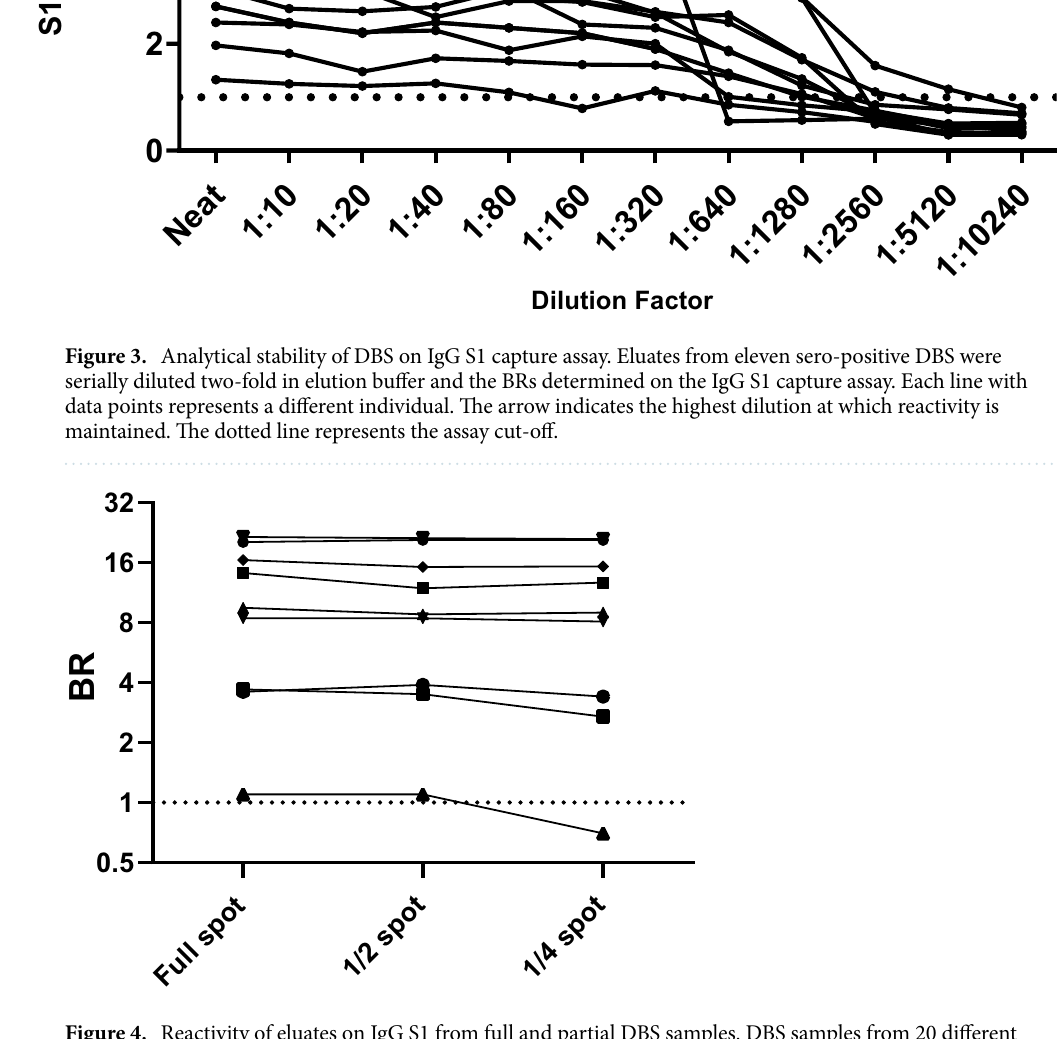
Figure 4. Reactivity of eluates on IgG S1 from full and partial DBS samples. DBS samples from 20 different patients were extracted as full, half and quarter spots as described in the methods. The reactivity of the three resulting eluates from each individual was tested in the IgG S1capture. The resulting reactivity (BRs) of the full, half and quarter spot eluates is shown for each individual, each line representing a different individual. The dotted line indicates the assay